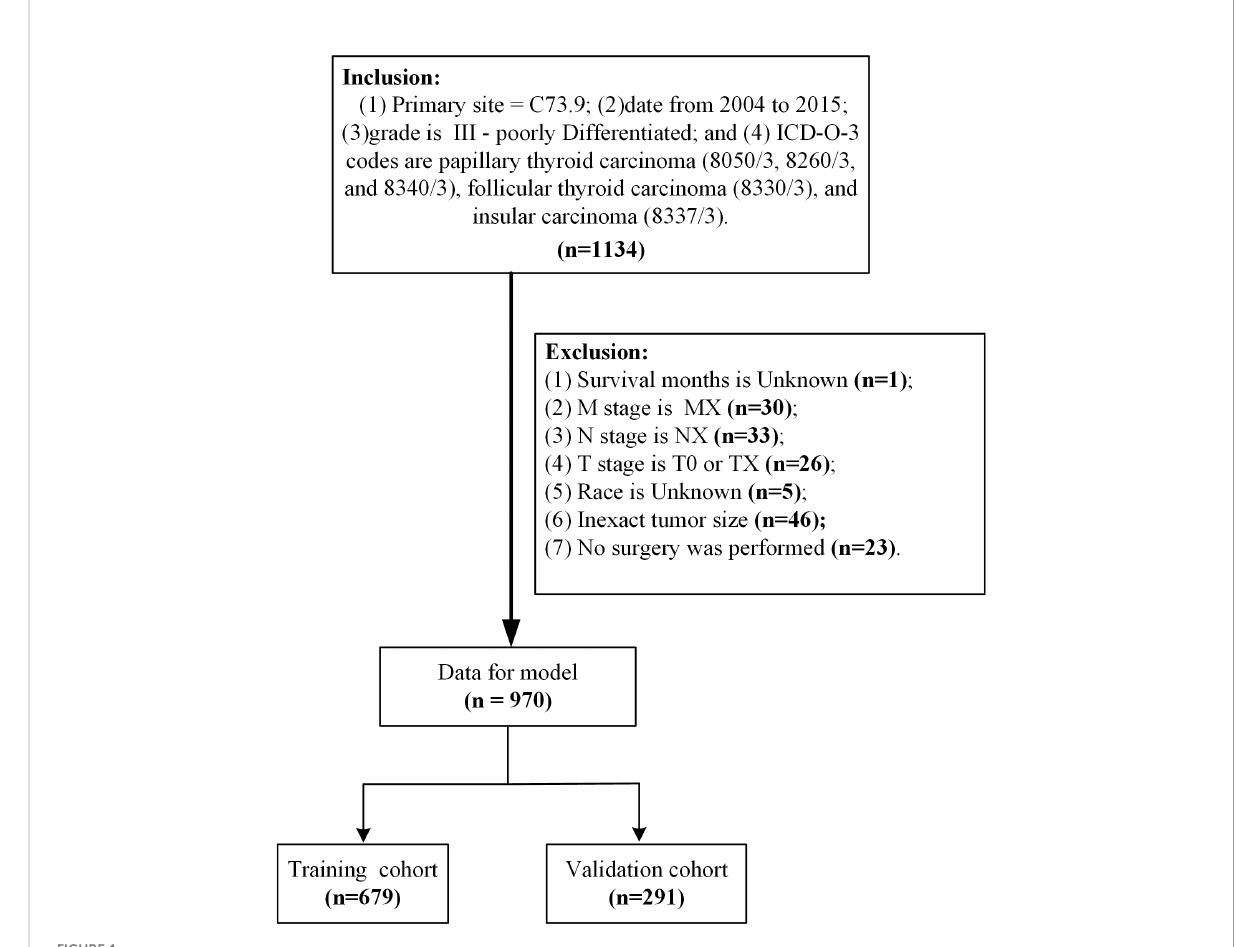
FIGURE 1 Flow chart detailing the selection of the patients in this